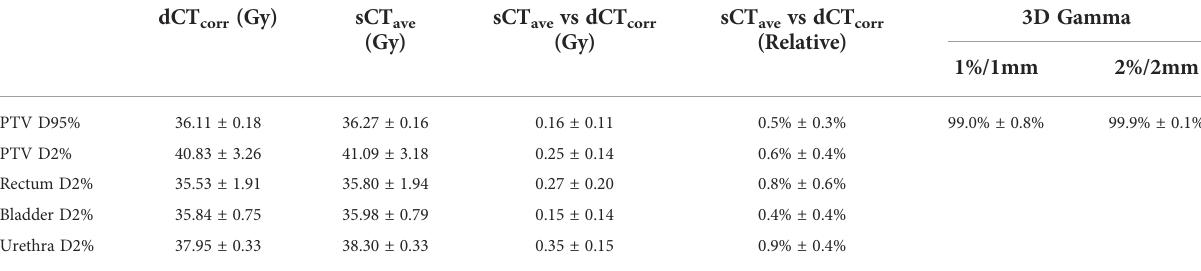
TABLE 3 DVH metrics of dCT corr and sCT ave , the comparison between sCT ave and dCT corr in DVH metrics and 3D gamma analyses with 1%/1 mm and 2%/2 mm in a ROI where the dose is larger than 10% of the maximum dose in each clinical